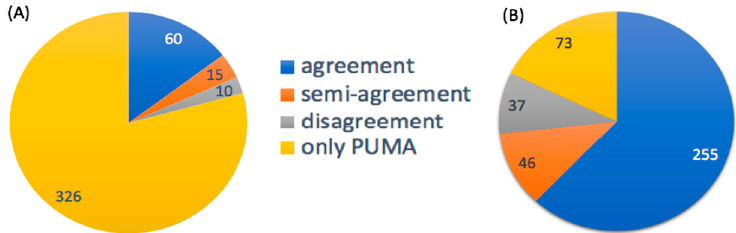
Figure 6. Metabolite annotations attained with PUMA against those identified by: ( A ) searching spectral databases, HMDB and METLIN, and ( B ) BioCAn. The blue slice in each pie represents “agreement”. The orange and gray slices represent “semi-agreement” and “disagreement” respectively. Finally, the yellow slice represents the number of mass measurements that could only be annotated by PUMA.